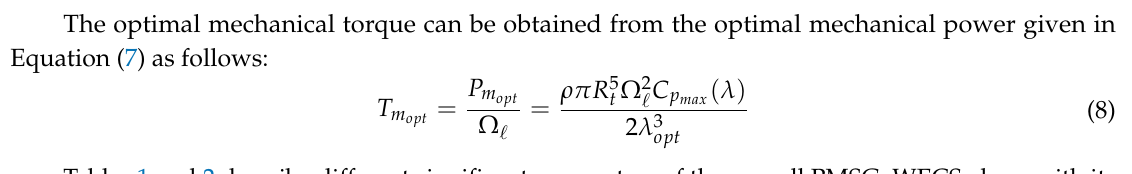
Figure 2. Wind turbine mechanical power output under different wind speeds.